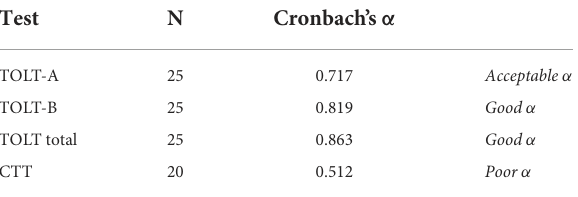
TABLE 2 Results of reliability